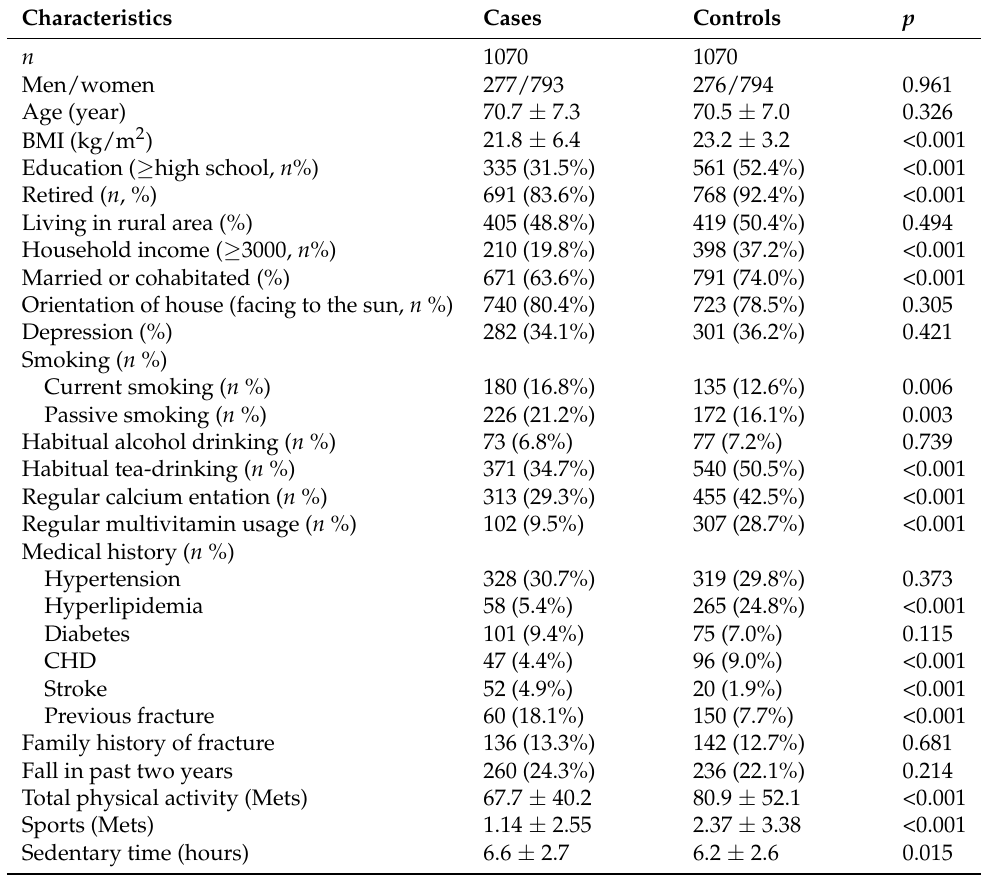
Table 1. Demographics and selected risk factors of fracture by cases and controls in Chinese elderly men and women of Guangzhou,